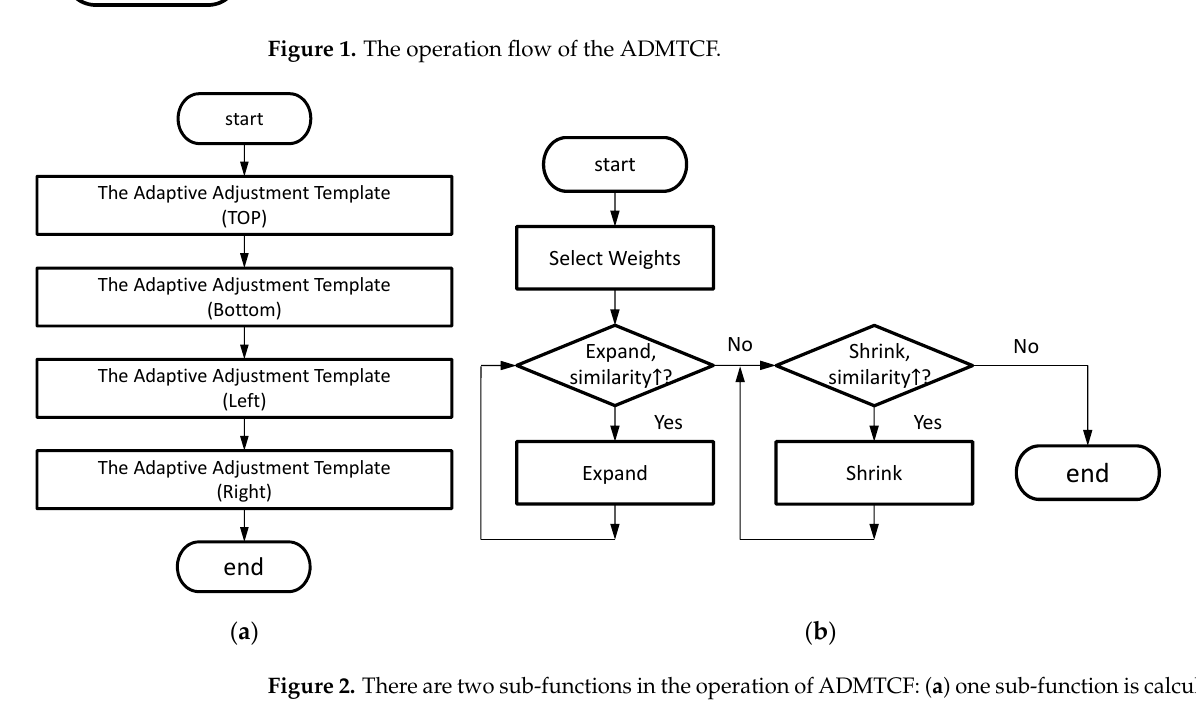
Figure 2. There are two sub-functions in the operation of ADMTCF: ( a ) one sub-function is calculating the response that is used to obtain the response of the four templates after adaptively resizing forward up, down, left, and right directions; ( b ) another sub-function is called the adaptive adjustment template which expands or shrinks the size of the